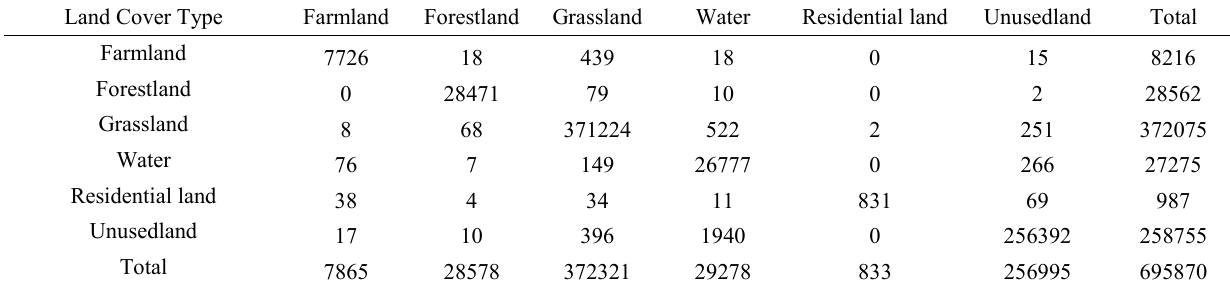
Tab.2 Land Use Change Matrice for the period of 1980- 2000 （ km 2 ）